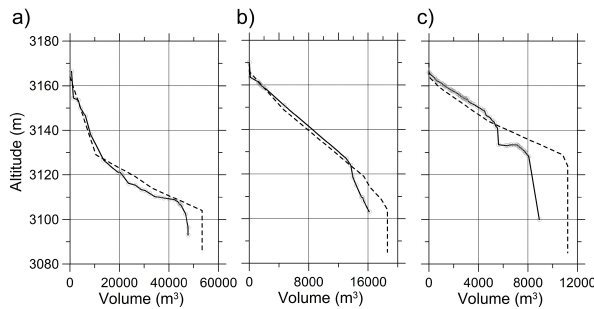
Fig. 10. Accumulated water volume vs. depth extracted by pumping (solid line) and water volume estimated with 3-D-SNMR (dashed line): (a) August–October 2010; (b) September–October 2011; (c) August 2012.